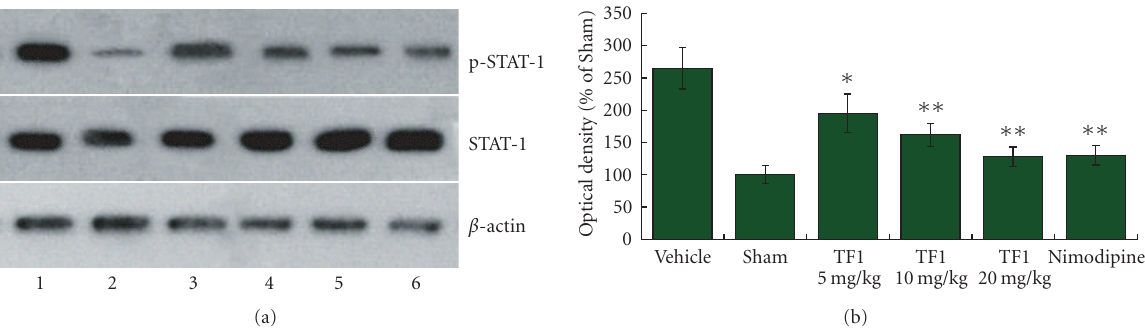
Figure 7: (a) Western blotting showed levels of STAT-1 in brain tissue of rats. Lanes 1–6: Vehicle, Sham, TF1 (5mg · kg − 1 ), TF1 (10mg · kg − 1 ), TF1 (20mg · kg − 1 ), Nimodipine. (b) Statistical analysis revealed that theaflavin-treatment markedly decreased STAT-1 phosphorylation dose dependently, ∗ P < . 05, ∗∗ P < .